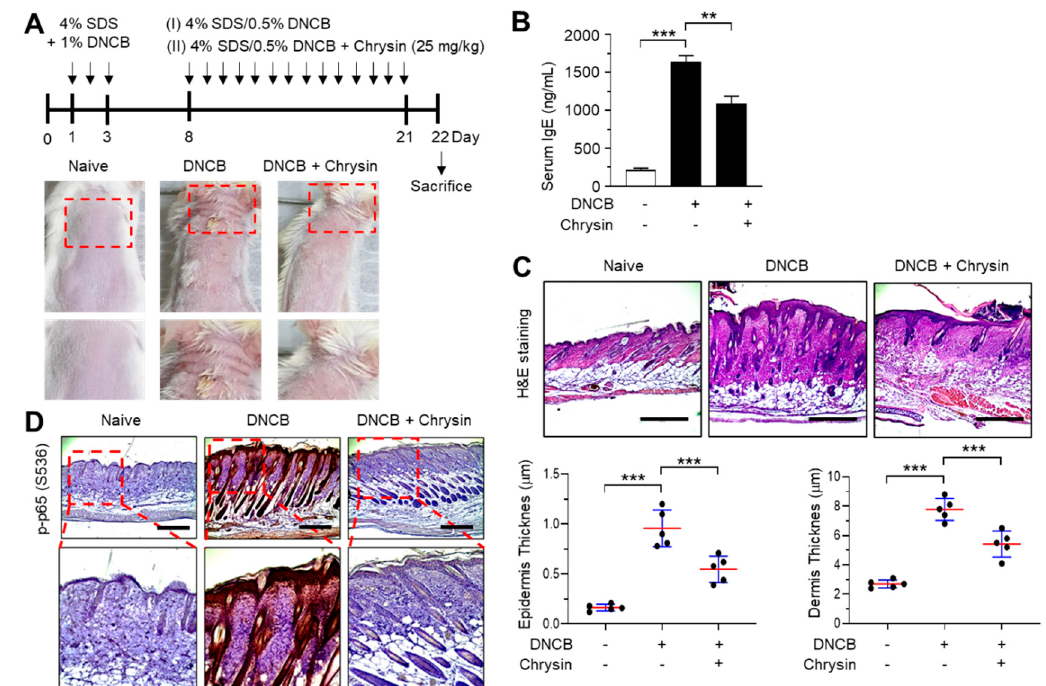
Figure 5. Effect of chrysin on the inhibition of NF- κ B in 2,4-dinitrochlorobenzene (DNCB)-induced skin lesions. ( A ) Illustration of the experimental schedule for the induction of atopic dermatitis (AD)-like skin lesions and treatment with chrysin (top). Representative images depicting the phenotype of naïve, DNCB-induced skin lesions, and DNCB + chrysin (25 mg/kg)-treated skin in BALB/c mice (bottom). The areas in the dashed boxes are enlarged in the bottom panels. ( B ) Blood samples were collected immediately before sacrifice on day 22, and the total serum immunoglobulin E (IgE) levels were measured by the enzyme-linked immunosorbent assay. Data are expressed as the mean ± SD ( n = 3). ** p = 0.0002 and *** p < 0.0001 by Dunnett’s multiple comparisons test. ( C ) Histological analysis. Paraffin-embedded skin sections were stained with hematoxylin and eosin (H&E). Scale bar, 400 μ m. The thicknesses of the epidermis and dermis were measured using ImageJ. Data are expressed as the mean ± SD ( n = 3). *** p < 0.001 by Dunnett’s multiple comparisons test. ( D ) Immunohistochemical staining of phosphorylated p65 (p-p65) in Ser536 in skin tissues treated with DNCB and DNCB + 0.2% chrysin. The sections were counterstained with H&E. Scale bar, 400 μ m. The areas in the dashed boxes are enlarged in the bottom panels.